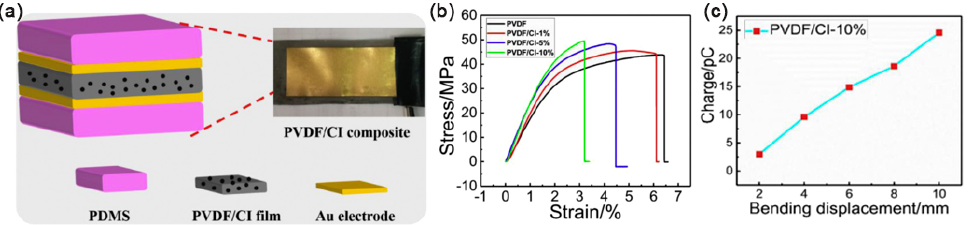
Figure 16. ( a ) Schematics of PVDF/CI composite structure; ( b )Tensile stress-strain curves of PVDF/CI films of CI particles in different content; ( c ) Piezoelectric charge variation of PVDF/CI-10% films at different bending displacement. Adapted with permission from Ref. [112]. Copyright 2018, copyright Elsevier B.V.